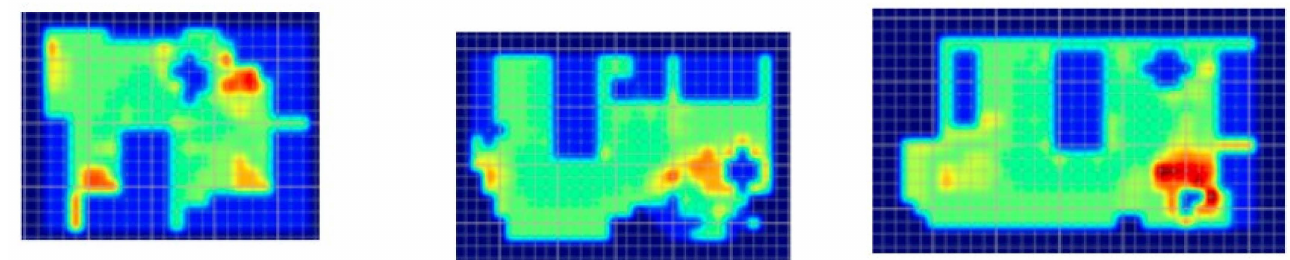
Figure 2. Heat maps depicting risk generated by the computer algorithm. A color gradient of blue representing low risk and red representing high risk was chosen for visualizing risk